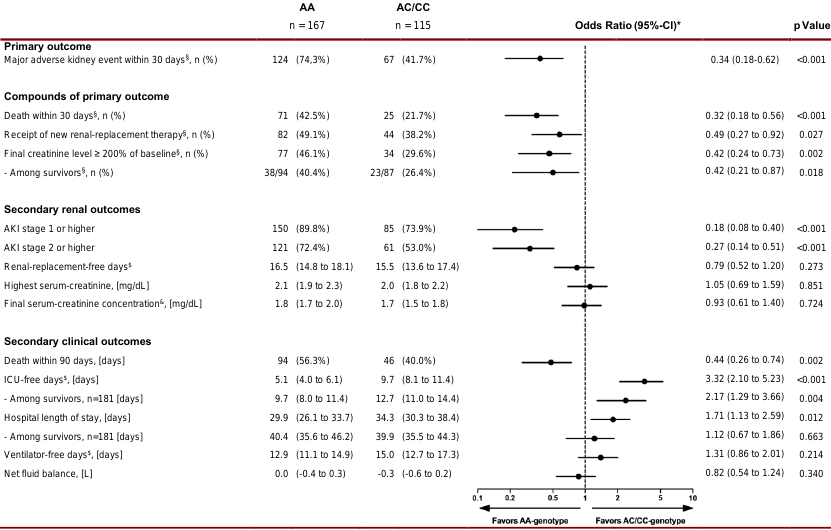
Figure 1. Analysis of rates and odds ratios for primary, secondary renal, and secondary clinical outcomes in septic patients stratified for their AQP5 -1364 A/C promoter polymorphism. Data are presented as n (%) or mean (with 95%-CI). AKI: Acute kidney injury; ICU: Intensive care unit. The odds ratio was calculated with AA serving as the reference group. Therefore, odds ratios of more than 1.0 indicate a higher frequency in AC/CC genotypes, an odds ratio of less than 1 indicate a higher frequency in AA genotypes. * Odds ratios were adjusted for pertinent confounders (i.e., age, sex, chronic kidney disease of stage 3 or higher, Sepsis-Related Organ Failure Assessment (SOFA) score, procalcitonin-concentration, and septic shock). § A major adverse kidney event is defined as a composite endpoint of death, receipt of new renal-replacement therapy, or final creatinine level that was at least 2-fold higher than the estimated baseline level within 30 days. $ Renal-replacement-free days, ICU-free, and ventilator-free days refer to the number of days on which the patient was alive and free from the specific therapy within the first 30 days after enrollment. & Final creatinine concentration on day 30, ICU-discharge, or before death, whichever occurred first.